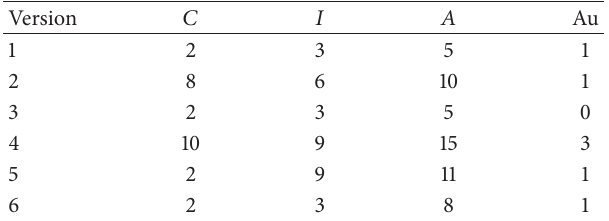
Table 8: The QoP evaluation of the analysed versions of TLS protocol.